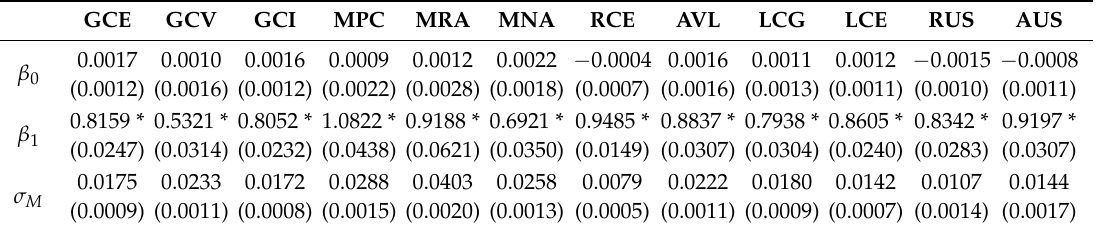
Table 4. Linear regression results for the fund mapping model (2) for each respective fund and the corresponding hedging instrument. Mutual fund descriptions are provided in Table 1. For Canadian equity funds, the hedging instrument is the TSX 60 index futures. For US equity funds, the hedging instrument is the S&P 500 index futures. GCE GCV GCI MPC MRA MNA